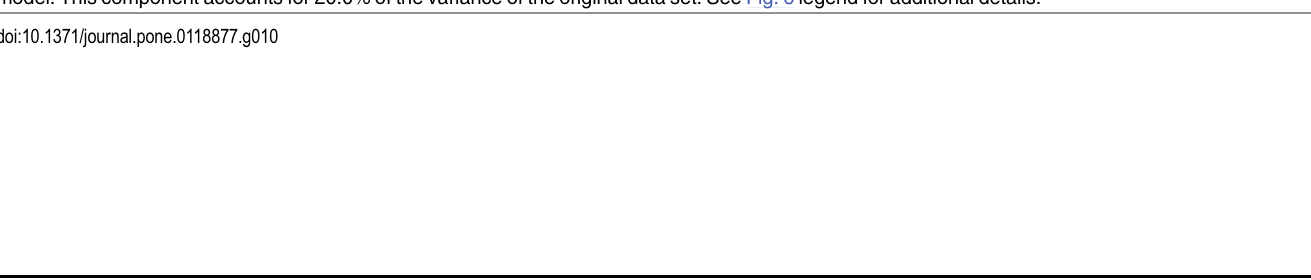
PLOS ONE | DOI:10.1371/journal.pone.0118877 March 26,